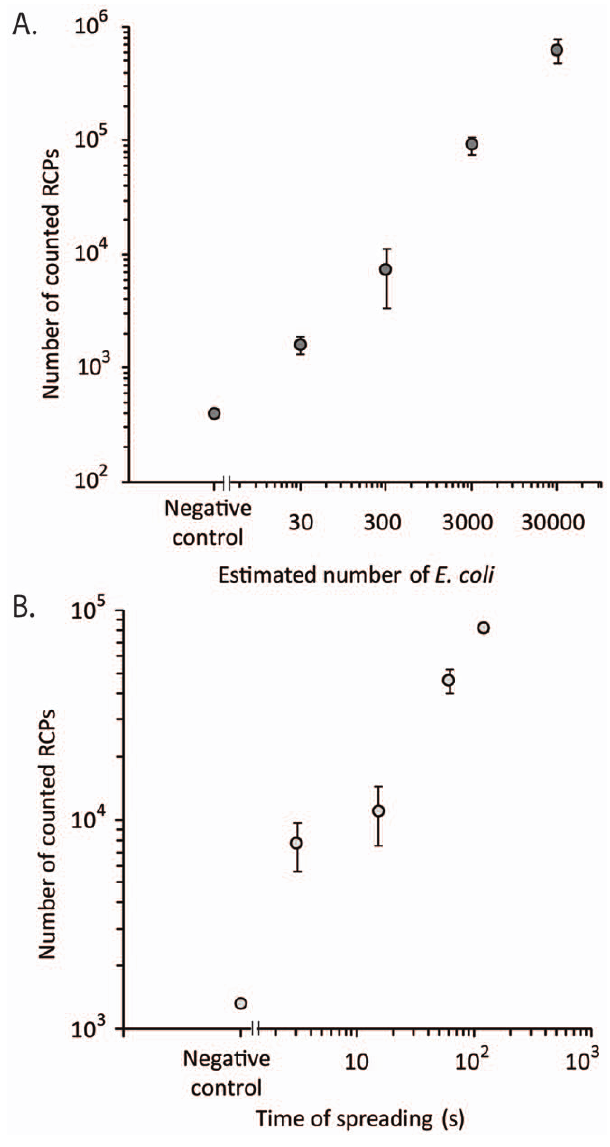
Figure 3. Identification of bacteria using padlock probe-based genetic analysis. A) Quantitative response measured in a dilution series of EC DNA. Error bars, 6 1 s.d.; n=3. B) Detection and identification of EC bacteria in environmental samples of air. All air samples were collected for 15 min, using the indicated spreading times for release of bacteria. Error bars, 6 1 s.d.; n=3.